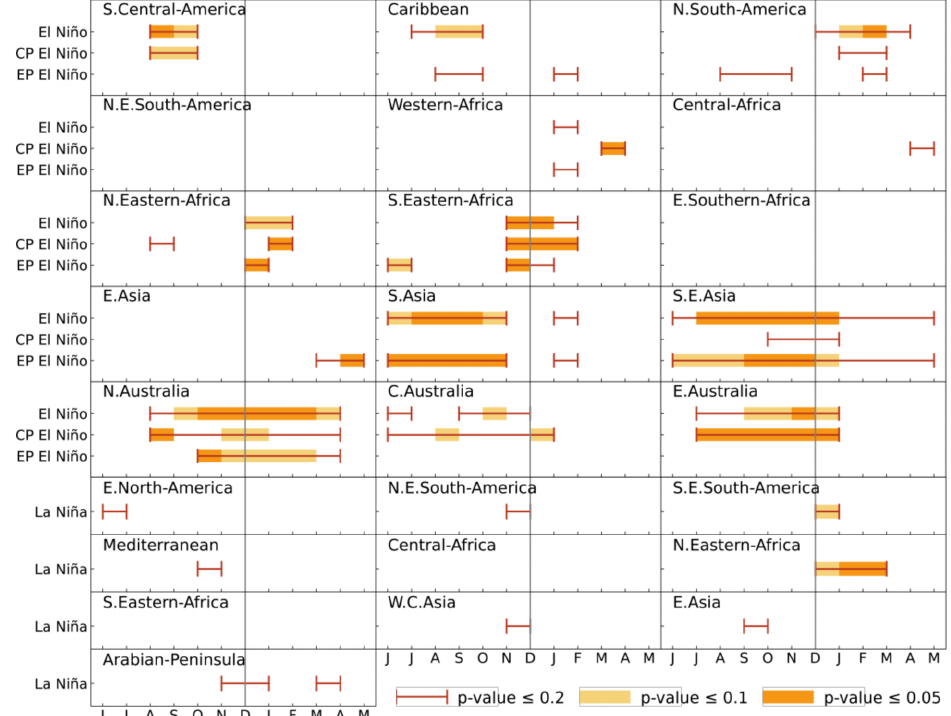
Figure 7. Comparisons of ENSO-induced drought timing and duration for SPI3 during El Niño, CP El Niño, EP El Niño, and La Niña. Light and dark filled bars indicate the statistical significance at the 90% and 95% confidence level of drought coverage from June to the next May, respectively. Error bars represent the statistical significance of drought coverage at the 80% confidence